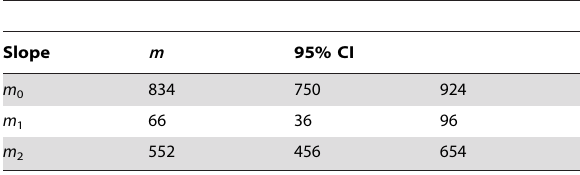
Table 1. Comparison of time dependent HYP uptake by method.